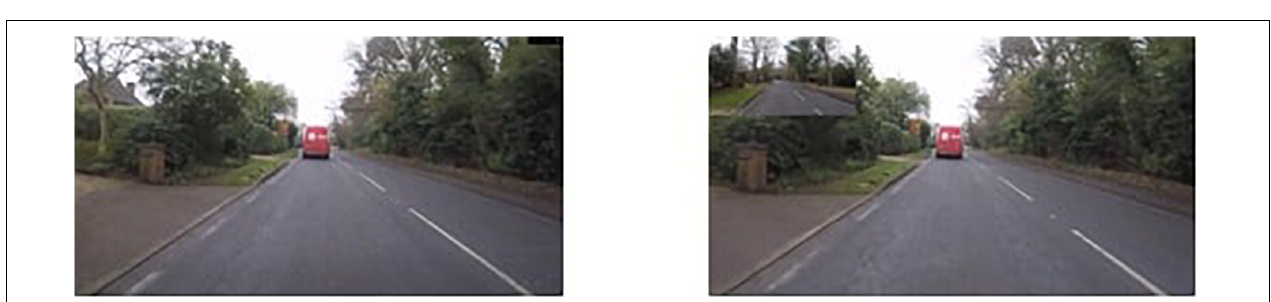
FIGURE 1 | Examples of different road types: (A) motorways, (B) a roads, (C) minor country roads, and (D) residential areas.